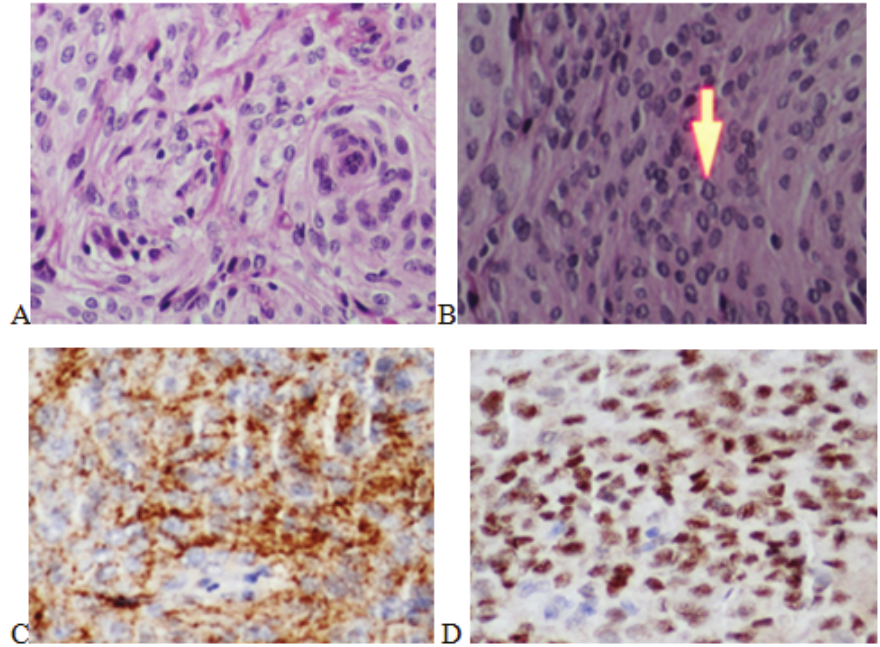
Figure 2. Histopathology. (A) Hematoxylin and Eosin (H&E) staining illustrating meningioma, tumoral cells with syncytial and whirling arrangement. (B) H&E staining showing intranuclear pseudo-inclusions. (C & D) Immunohistochemistry illustrating positive staining for Epithelial Membrane Antigen (EMA) (cytoplasmic), Progesterone Receptor (PR) (nuclear),